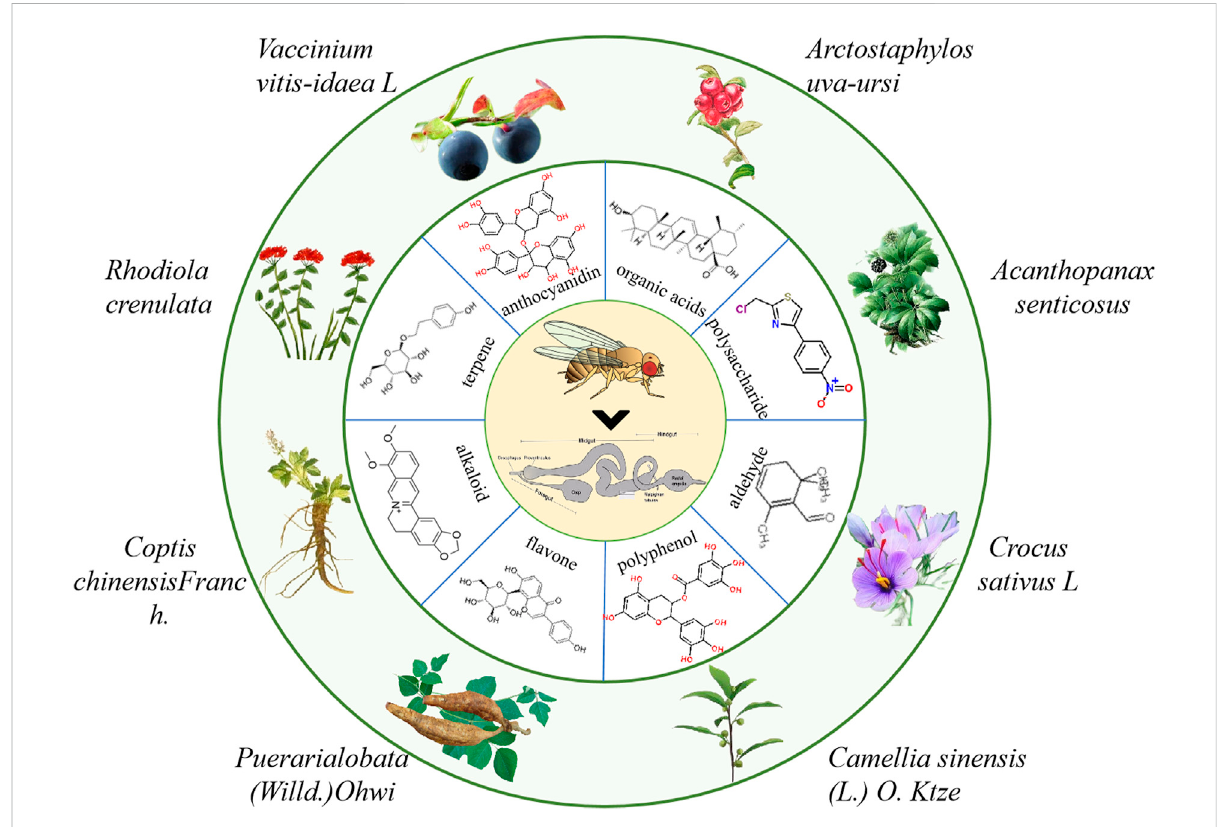
FIGURE 4 The information of partial natural products that play a crucial role in the treatment of IBD in fl